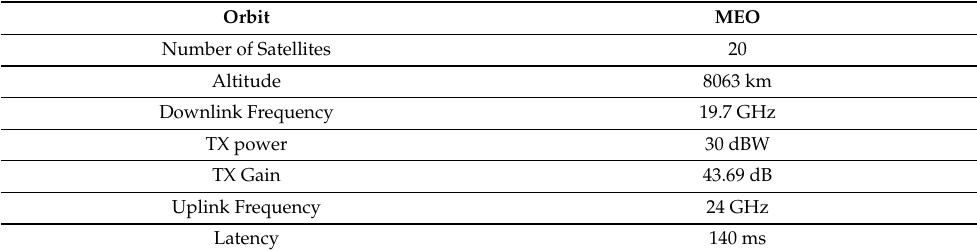
Table 3. Communications Satellite System Parameters.